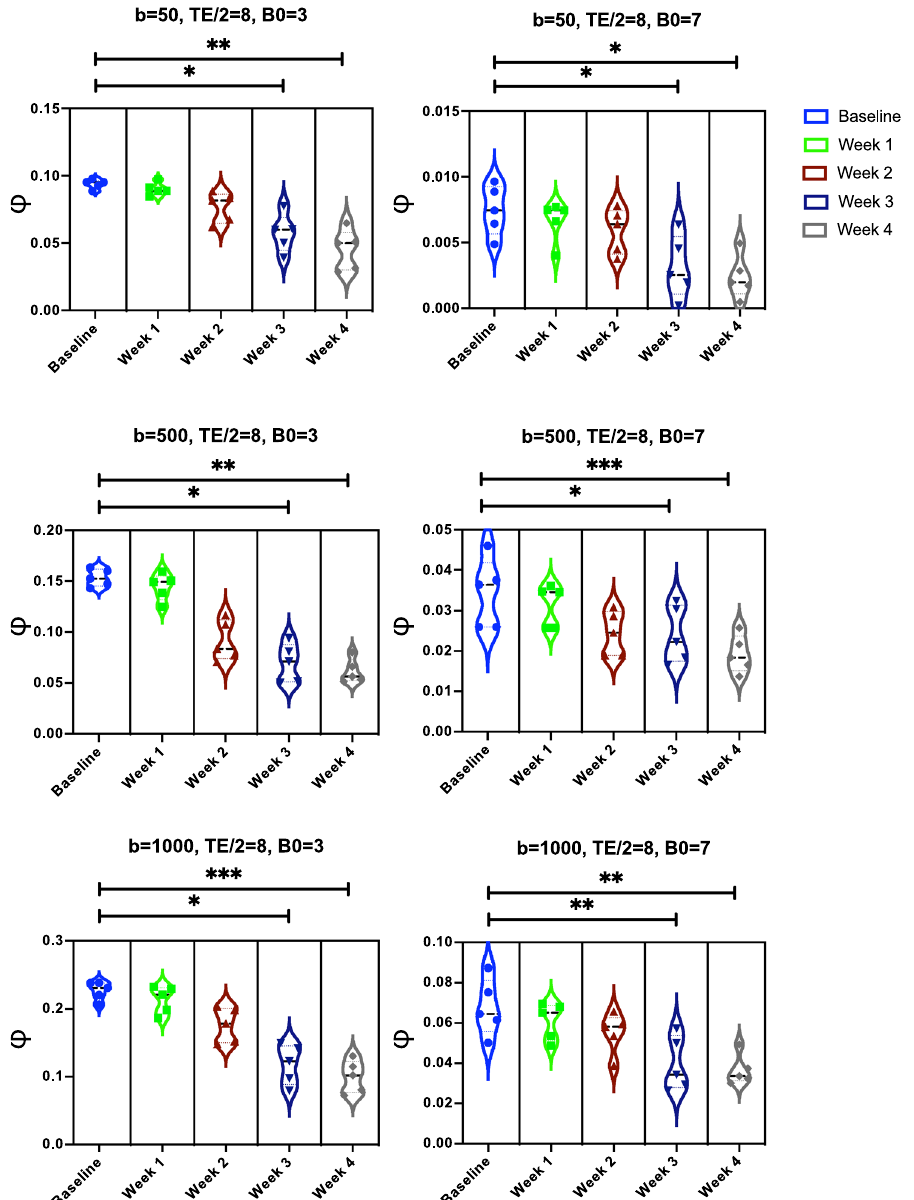
Figure 6. Statistical significance between the ratio of minimal signal loss φ simulated from our OCT angiograms before and after occlusion through our multi-directional IVIM scheme by involving